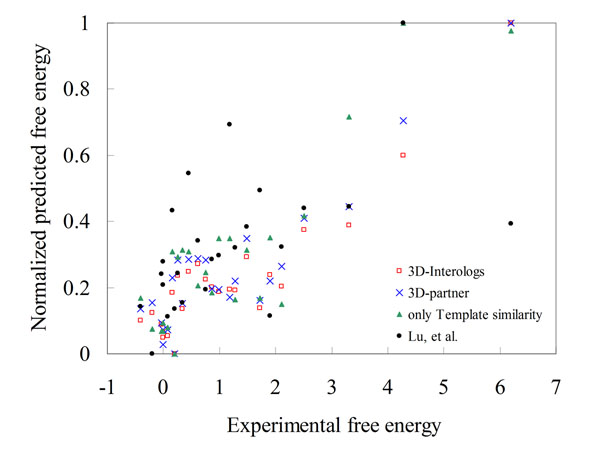
Evaluation of the 3D-interologs in binding affinities. The Pearson correlations between experimental free energies (ddG) and the predicted values of the 3D-interologs using four scoring functions, including 3D-interologs (red), 3D-partner (blue), Esim (only template similarity, green) and one matrix (black) proposed by Lu, et al., on 275 mutated residues selected from Alanine Scanning Energetics database.